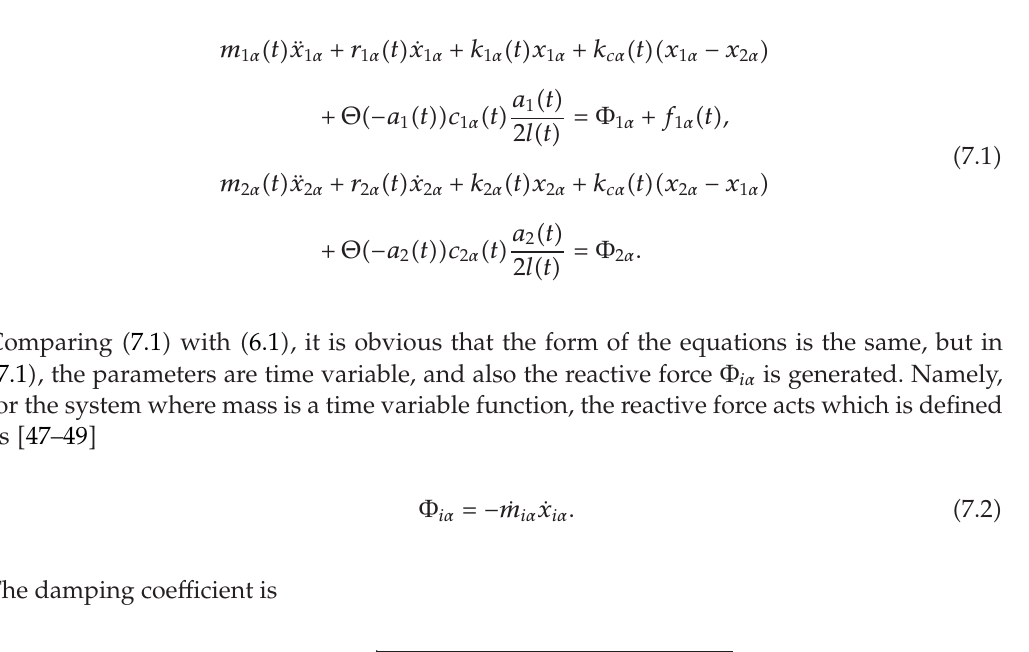
the two-mass model of asymmetric vocal folds with time variable parameters is plotted.